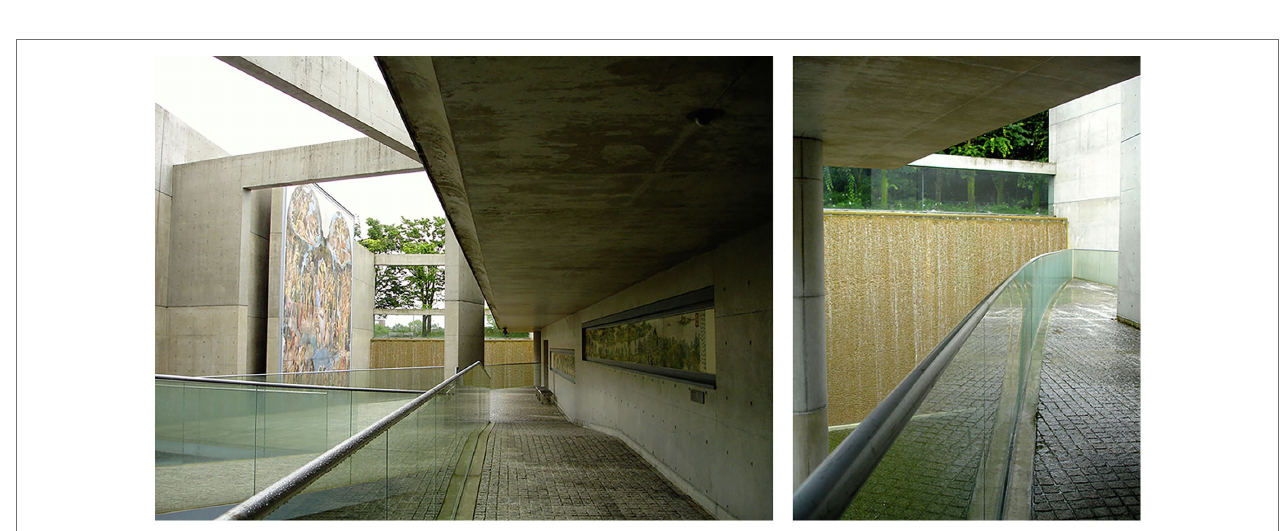
FIGURE 2 | Pavilion Incidental Space , Christian Kerez, Venice Architecture Biennale 2016, Venice, Italy. Photo credit: Jain Kwon.